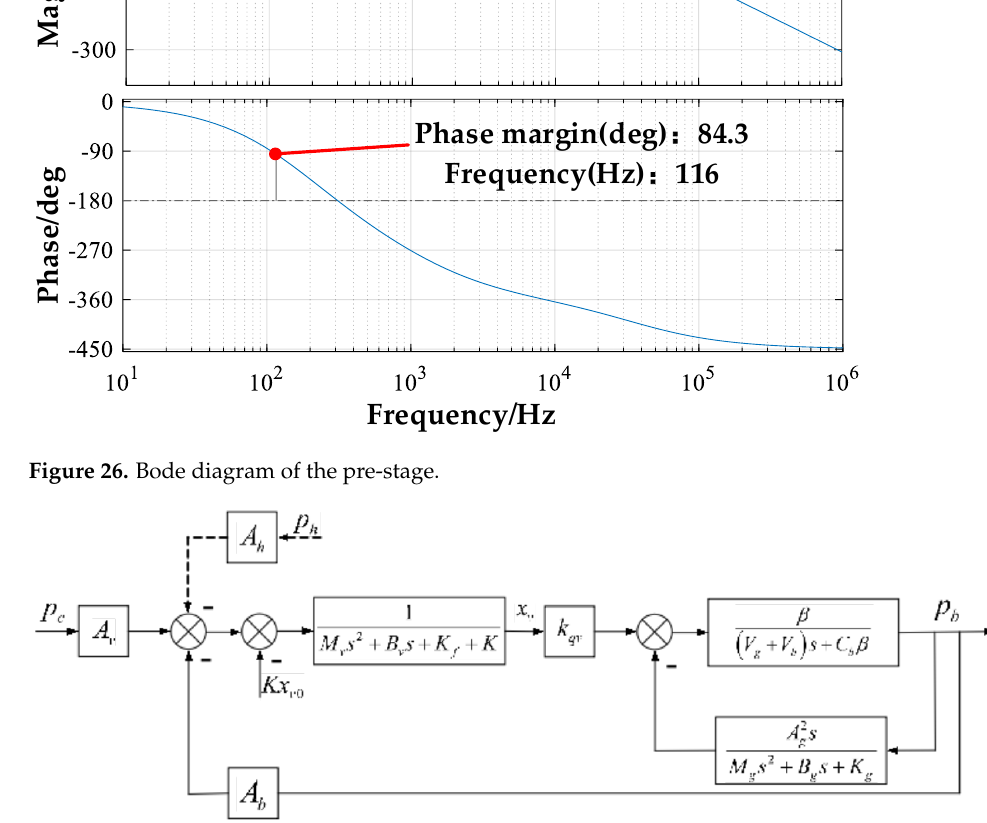
Figure 27. Power stage control block diagram.